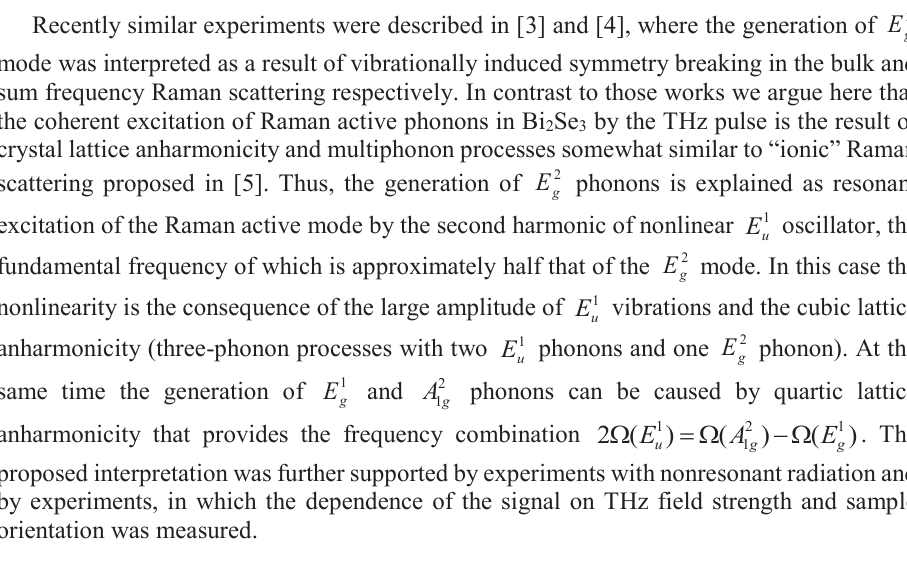
Fig. 1. (a) - Ultrafast response of Bi 2 Se 3 to the THz pulse. (b) - FFT spectra of three decay traces measured in succession (vertical axis is in the logarithmic